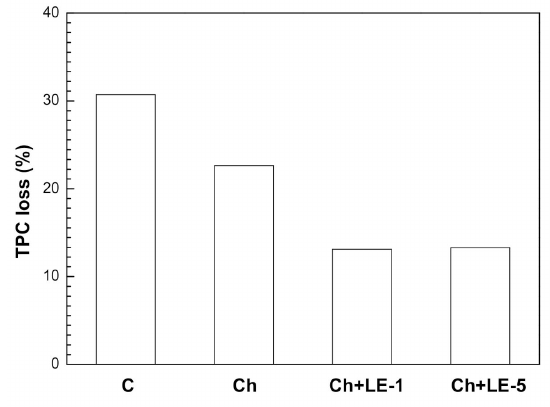
Figure 9. E ff ect of chitosan-licorice coatings on total phenolic compounds (TPC) of strawberries stored for 10 days at 4 ◦ C: C = uncoated; Ch = chitosan; LE1 = Chitosan + 1% of licorice extract; LE5 = Chitosan + 5% of licorice